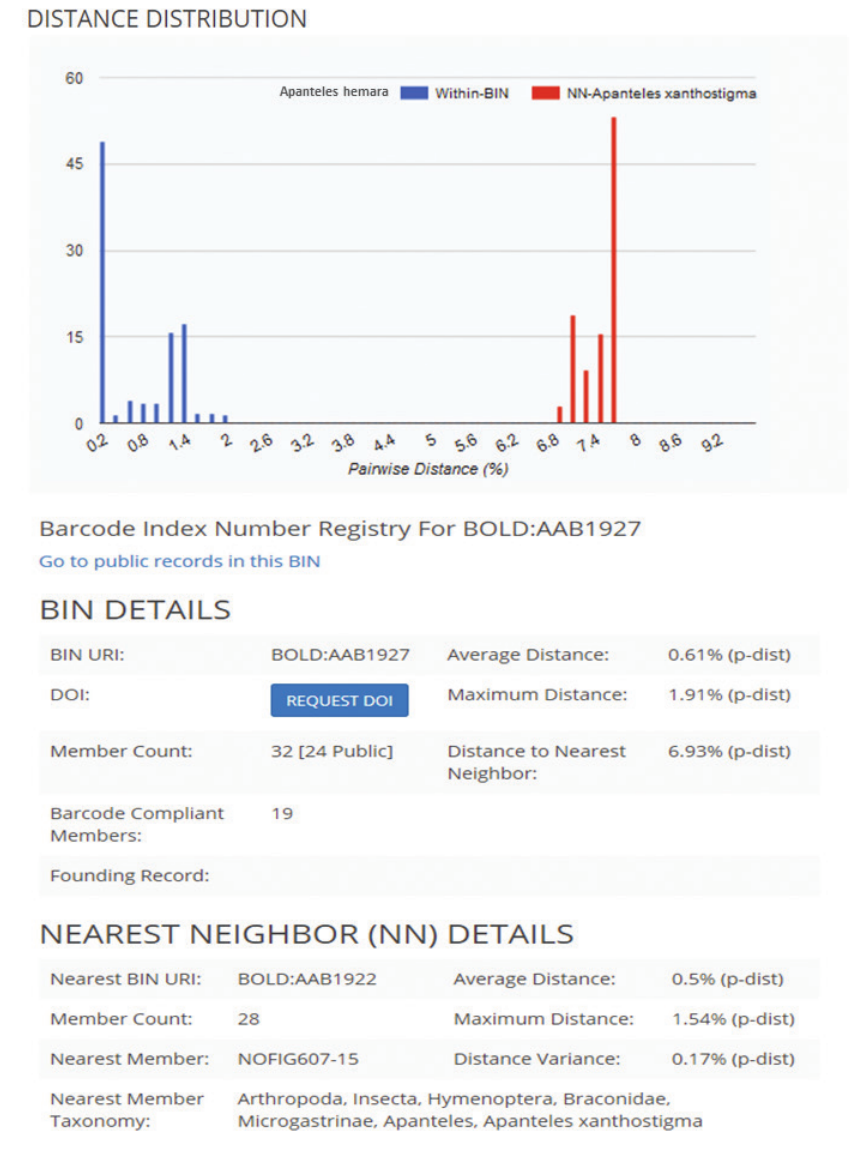
Figure 2. Details of the Barcode Index Number Registry for Apanteles hemara , data from BOLD (http://